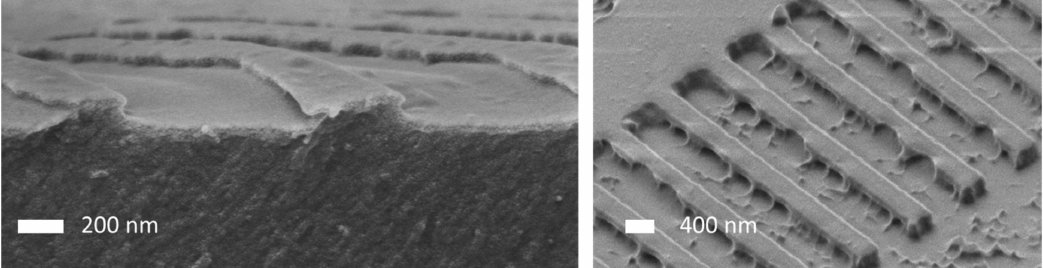
Figure 4. Left: cross-sectional SEM image of an imprint using an h-PDMS stamp and OrmoComp as imprinting material. Right: SEM image imprint using MD700 as stamp material and OrmoComp as imprint material.